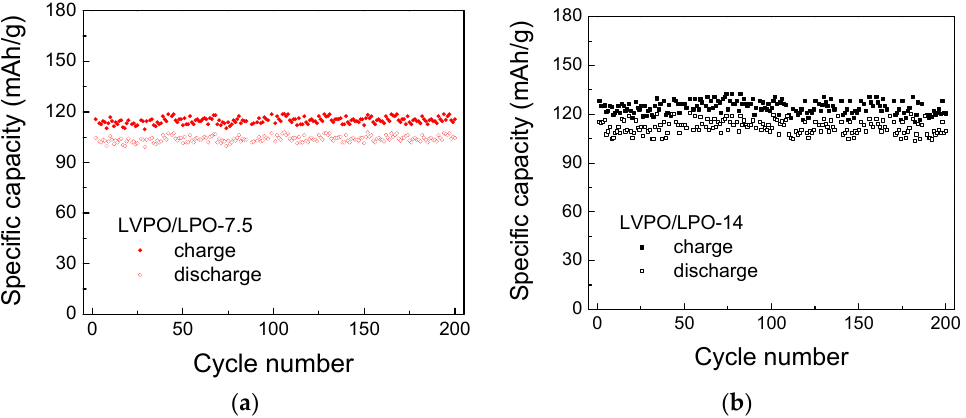
Figure 7. Long-term cycle performance at 1C up to 200 cycles in the voltage window 2.0–4.5 V for ( a ) Li 3 V 2 (PO 4 ) 3 (92.5 wt%)/Li 3 PO 4 (7.5wt%), ( b ) Li 3 V 2 (PO 4 ) 3 (86 wt%)/Li 3 PO 4 (14 wt%) samples.